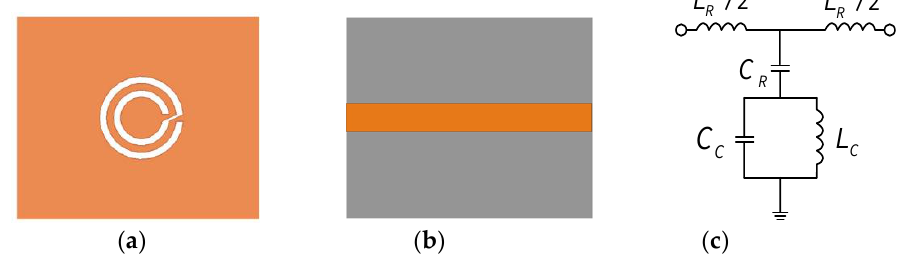
Figure 1. ( a ) Top view and ( b ) bottom view of the microwave sensor based on the Complementary Circular Spiral Resonator (CCSR); ( c ) Equivalent circuit of the sensor.